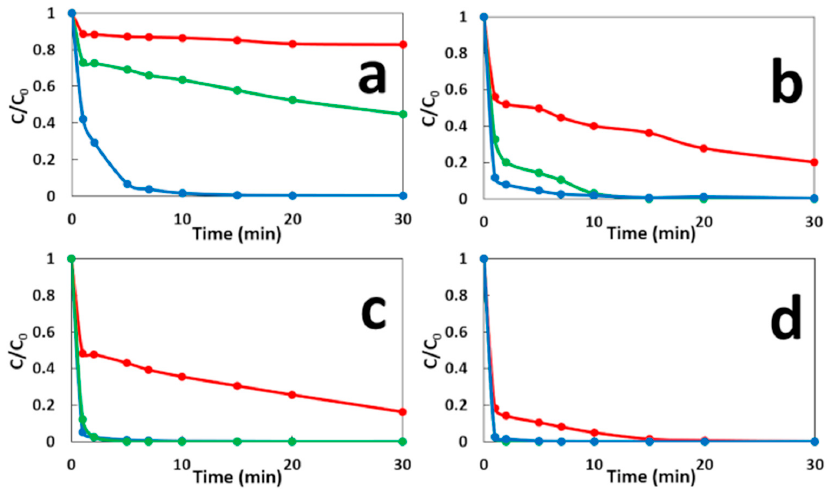
Figure 4. Effect of the cathode material on the decolorization of MG dye during the GF-A process (green line) and the GF-B process (blue line) for: ( a ) 2.7 mg ⋅ L − 1 of Fe 2+ /1 min immersion, ( b ) 8 mg ⋅ L − 1 of Fe 2+ /5 min immersion, ( c ) 11.8 mg ⋅ L − 1 of Fe 2+ /10 min immersion, and ( d ) 17.8 mg ⋅ L − 1 of Fe 2+ /20 min immersion. The CF process (red line) is presented for comparison.